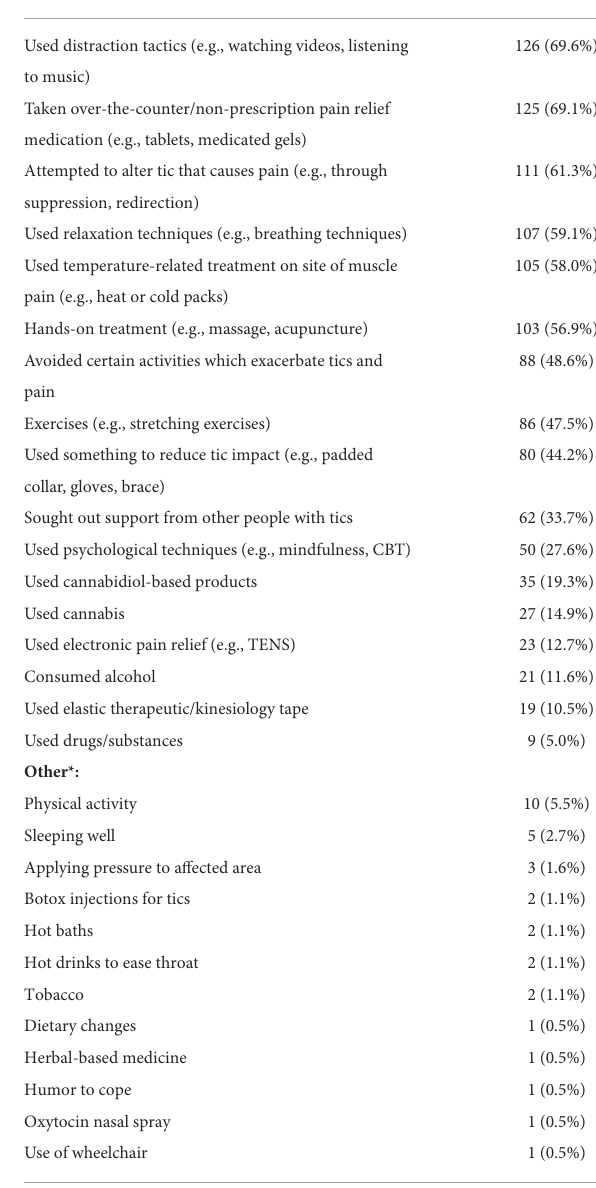
TABLE 6 Self-management techniques used to manage tic-related pain. N (%)